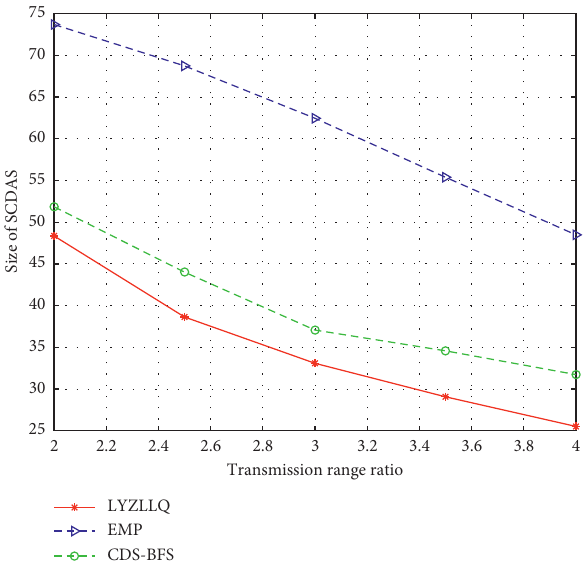
Figure 10: The impact of the ratio of the transmission